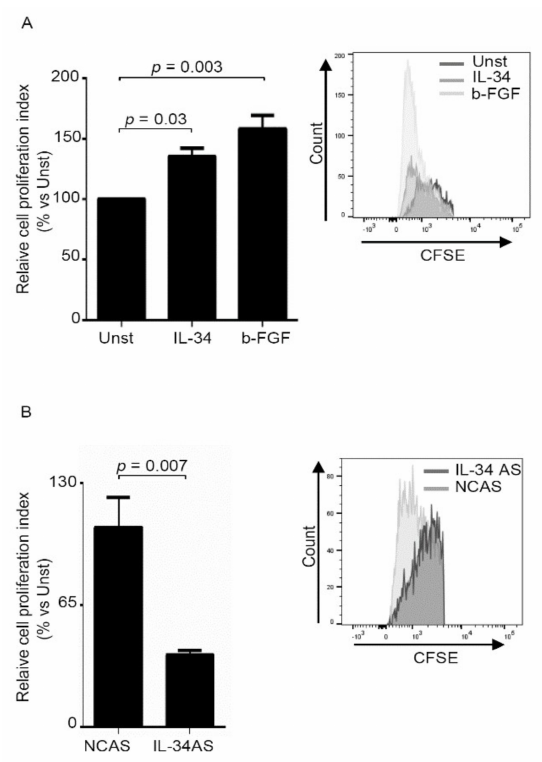
Figure 4. IL-34 enhances fibroblast proliferation. ( A ) Serum-starved normal fibroblasts (NFs) were stimulated with IL-34 (50 ng / mL) or basic-fibroblast growth factor (b-FGF) (20 ng / mL) for 48 h. Cell proliferation was evaluated by flow cytometry, and proliferation index was calculated with Modfit LT. Data indicate mean ± SEM of six independent experiments in which cells of six patients were analyzed. Right insets: representative histograms showing the expression of carboxyfluorescein diacetate succinimidyl ester (CFSE) in NFs analyzed by flow cytometry. ( B ) CAFs were transfected with negative control antisense oligonucleotide (NCAS) or IL-34 antisense oligonucleotide (IL-34 AS) for 48 h. Cell proliferation was evaluated by flow cytometry, and proliferation index was calculated with Modfit LT. Data indicate mean ± SEM of six independent experiments in which cells of six patients were analyzed. Right insets: representative histograms showing the expression of CFSE in CAFs analyzed by flow cytometry. UNST =